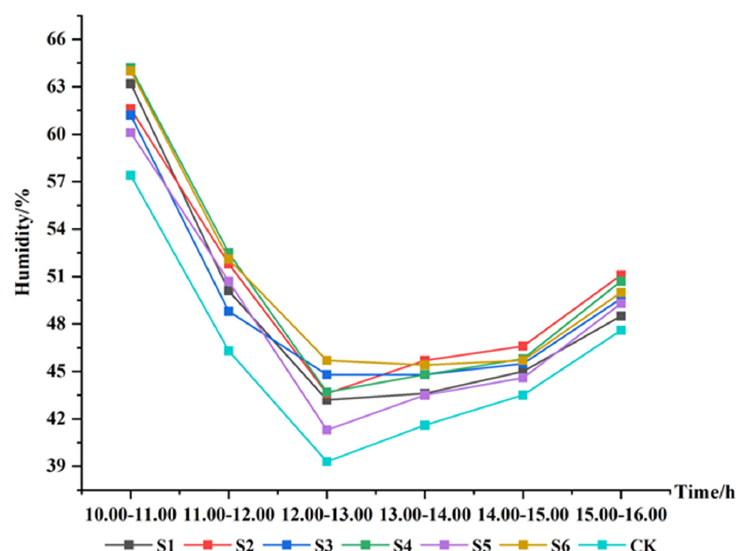
Figure 7. Relative humidity diurnal variation of the tree species (S1–S6).